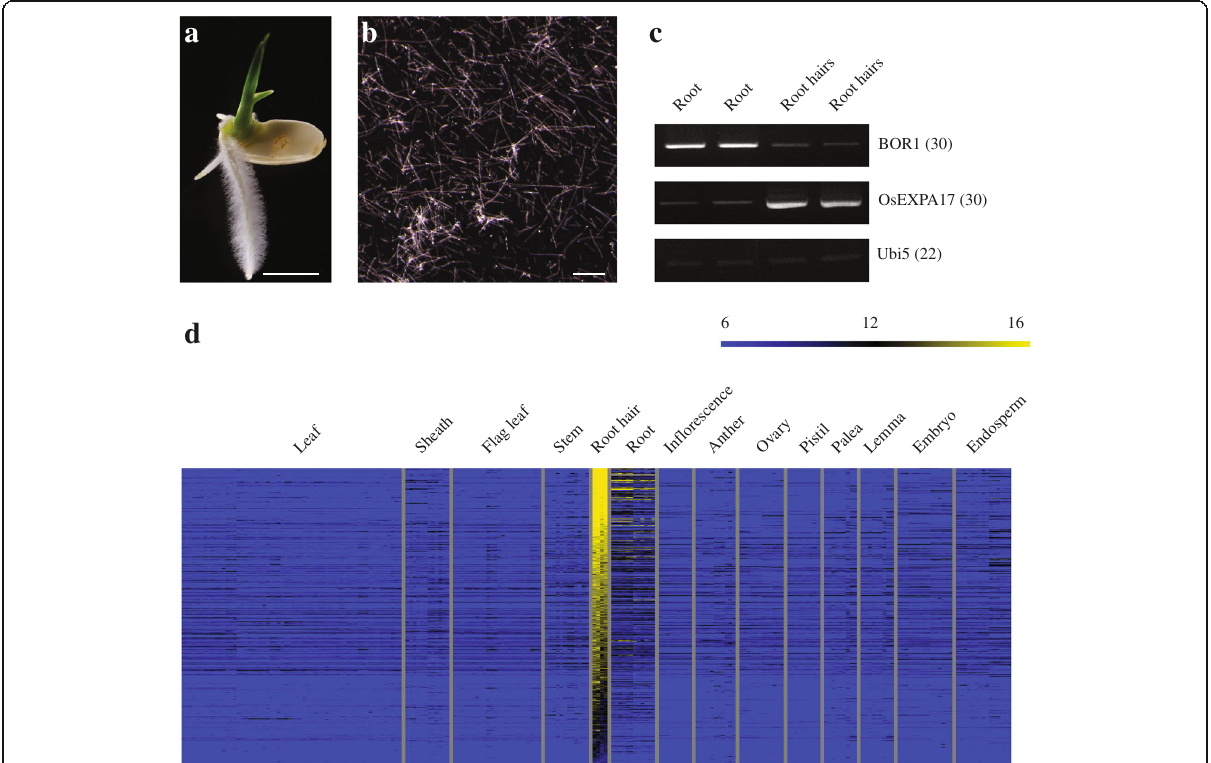
Fig. 1 Identification of genes preferentially expressed in rice root hairs. a Seedling at 3 DAG, prior to sample preparation. Scale bar = 5 mm. b Microscopic observation of root hairs. Scale bar = 0.1 μ m. c RT-PCR analysis of samples using 2 marker genes: OsBOR1 , negative marker showing root-preferential expression; and OsEXPA17 , positive control showing root hair-specific expression. Value in parentheses indicates number of PCR cycles. d Heatmap analysis of 409 genes preferentially expressed in root hairs. Yellow, high expression; dark-blue, low